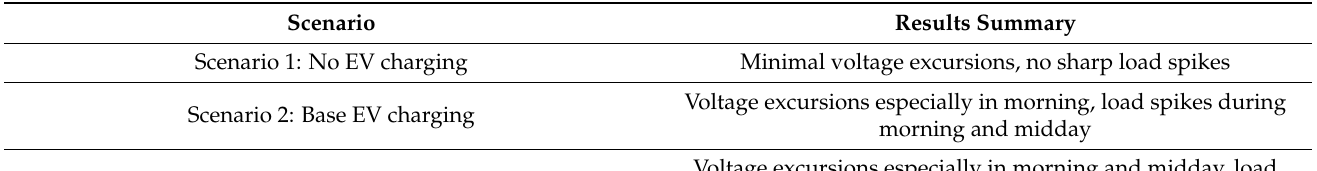
Table 3. Distribution system impact results summary by charging scenario.